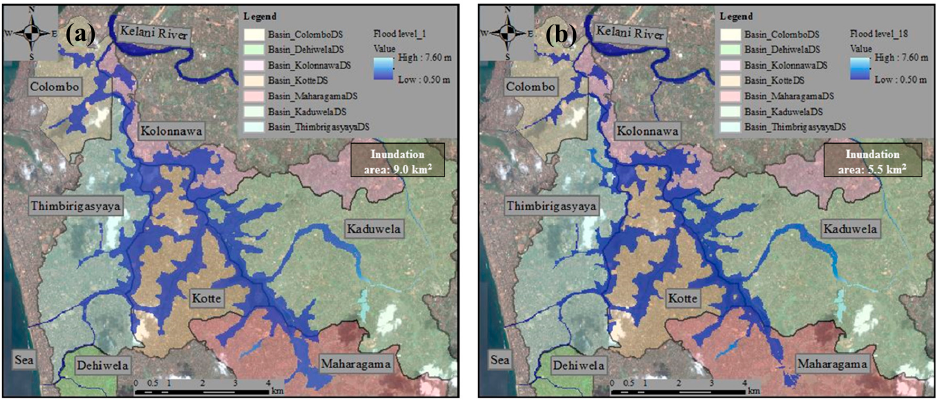
Figure 14. Inundation maps for 2010 rainfall: ( a ) with existing condition; ( b ) with all four countermeasures.